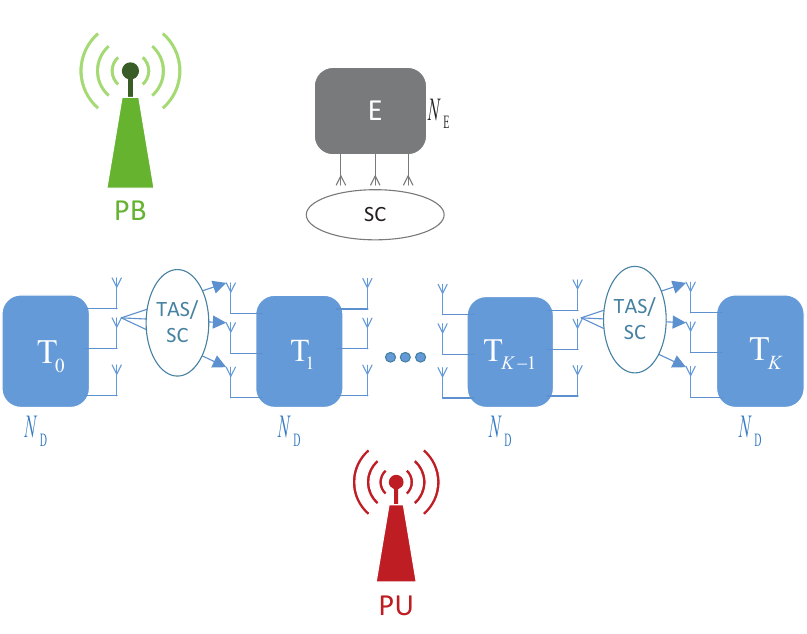
Figure 1. System model of the proposed